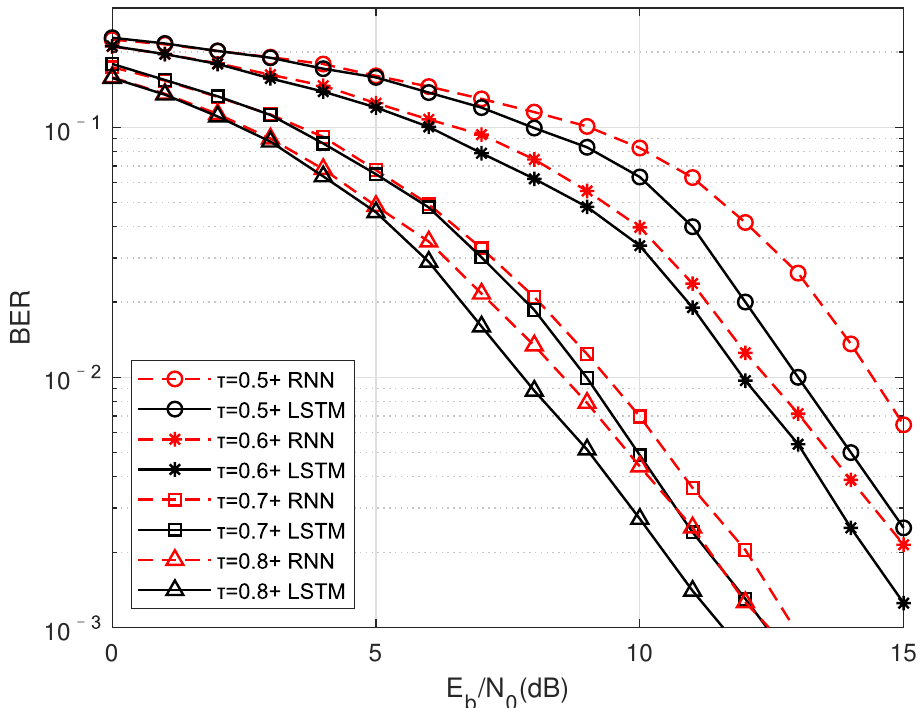
Figure 13. TU channel moving speed is 60 km/h, compare the performance of traditional RNN and LSTM